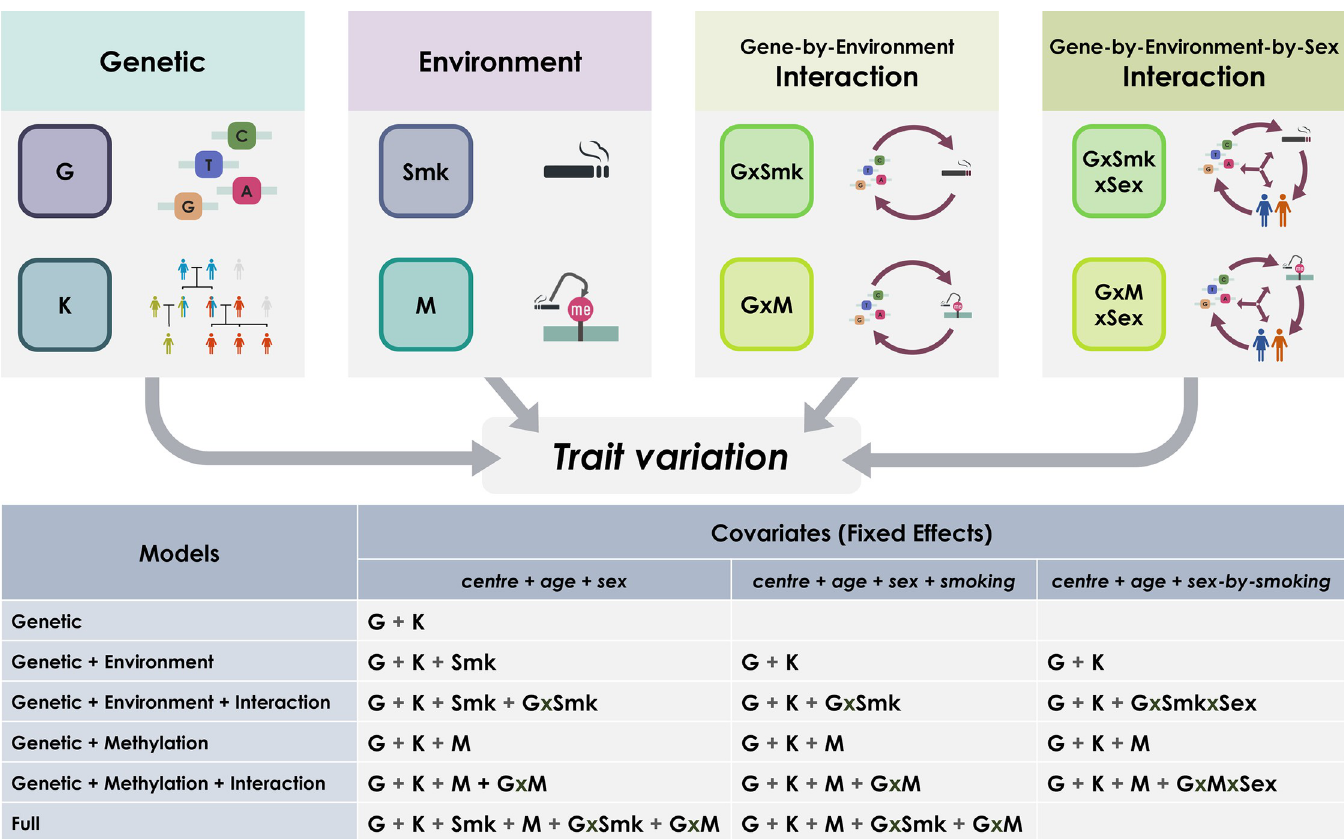
Fig 1. Summary of the experimental design of the study. The panels (above) represent the genetic and environmental components contributing to trait variation and used in the models (table below). Each cell shows the included random effects in each combination of model (row) and fixed effects (columns). G: Genomic, K: Kinship, GxSmk: Genome-by-Smoking, M: Methylation, GxM: Genome-by-Methylation, GxSmkxSex: Genome-by-Smoking-by-Sex, GxMxSex: Genome-by-Methylation-by-Sex. Models applied to different data sets varied depending on data